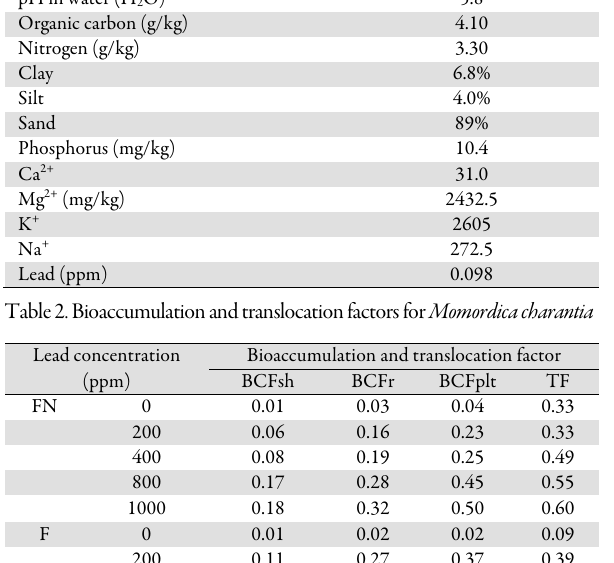
Table 1. Physical and chemical characteristics of soil used for the experiment Characteristics